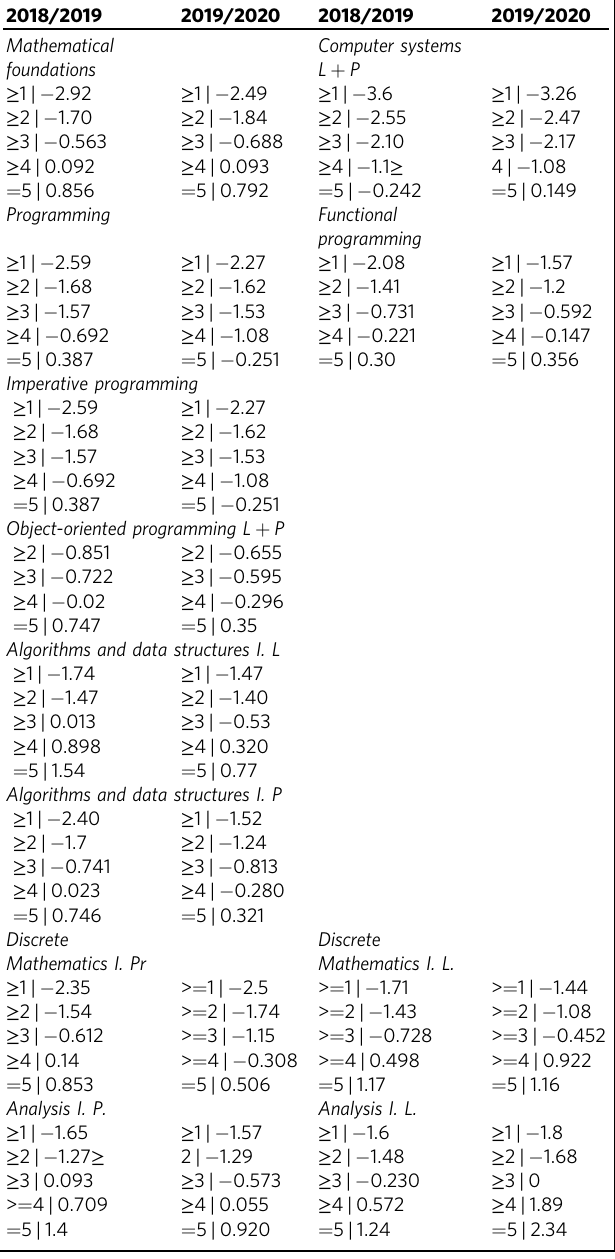
Table 2 IRT-model on subjects of the fi rst two semesters of CS degree programme.